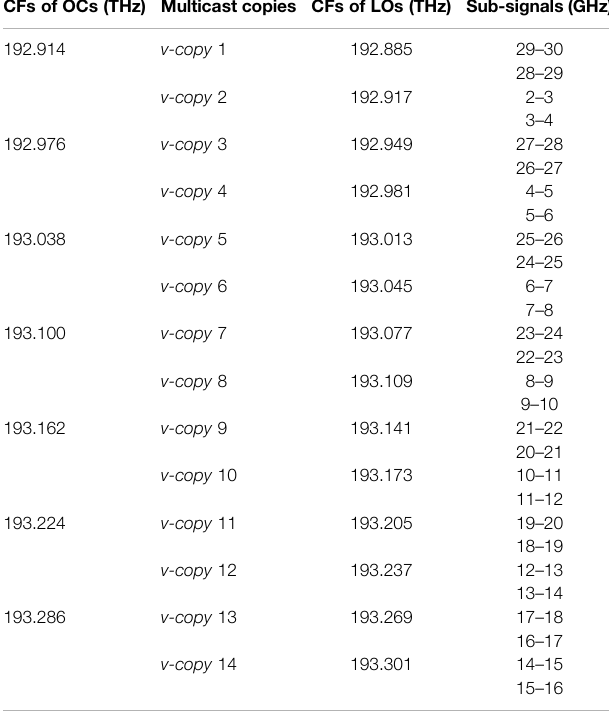
TABLE 3 | Relationship among v-copies, LOs, channelized components for dynamics 4 GHz signal.